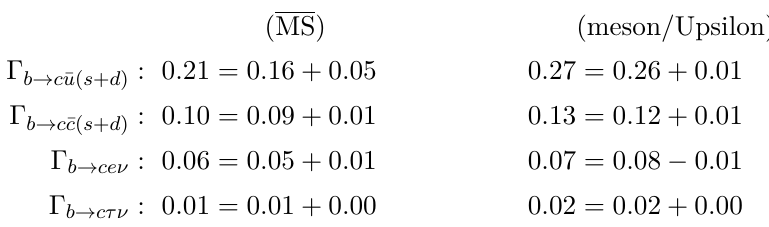
p in the three different ∆ p Γ Bc